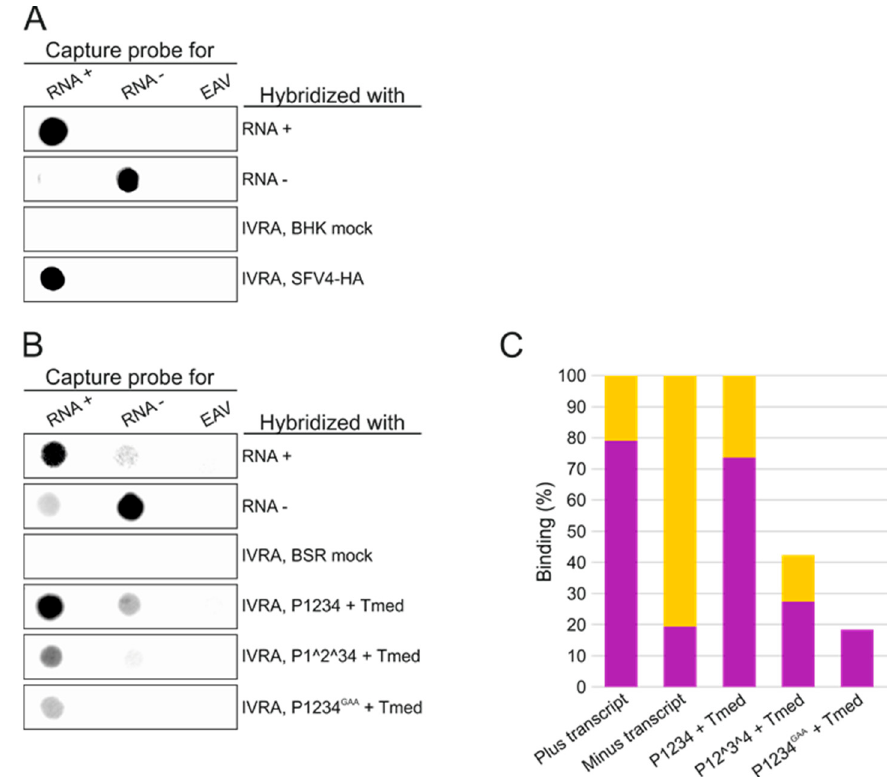
Figure 5. Determination of the polarity of in vitro synthesized RNA. ( A ) RNA probes with the sequence of the 3 ′ end of the SFV genome, recognizing minus-strand RNA (RNA − ), or its complementary sequence, recognizing plus-strand RNA (RNA+), were immobilized on membranes. As a negative control, an unrelated transcript (equine arteritis virus (EAV)) was also immobilized. The membranes were then hybridized with 32 P-labeled SFV transcripts of positive or negative polarity as well as 32 P-labeled IVRA products. IVRA reactions with PNS samples from mock and SFV-infected cells were included; ( B ) RNA probes with the plus sequence of Tmed, recognizing minus-strand RNA (RNA − ), or its complementary sequence, recognizing plus-strand RNA (RNA+), were immobilized on membranes as well as EAV transcript followed by hybridization with 32 P-labeled Tmed plus and minus transcripts as well as 32 P-labeled IVRA products. PNS samples from both mock and transfected cells were included; ( C ) binding of Tmed plus and minus transcripts as well as IVRA products to the capture probes was quantified from two independent experiments. The binding of the IVRA products made by replication complexes (RCs) from P1^2^34 or P1234 GAA + Tmed-transfected cells were normalized to the binding of the IVRA products made by RCs from P1234 + Tmed-transfected cells. Magenta indicates binding to the capture probe for the plus-strand RNA and orange to the capture probe for the minus-strand